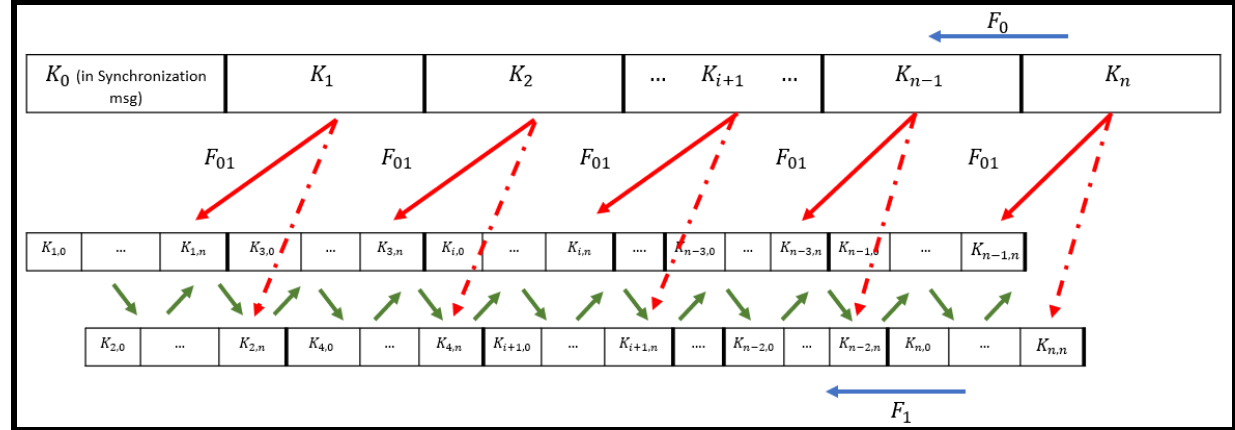
Figure 2. General Structure of the proposed Hybrid TLI-µTESLA Protocol.